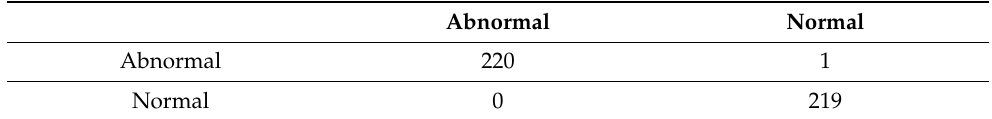
Table 3. Confusion matrix for the BraTS dataset using the BTR method.